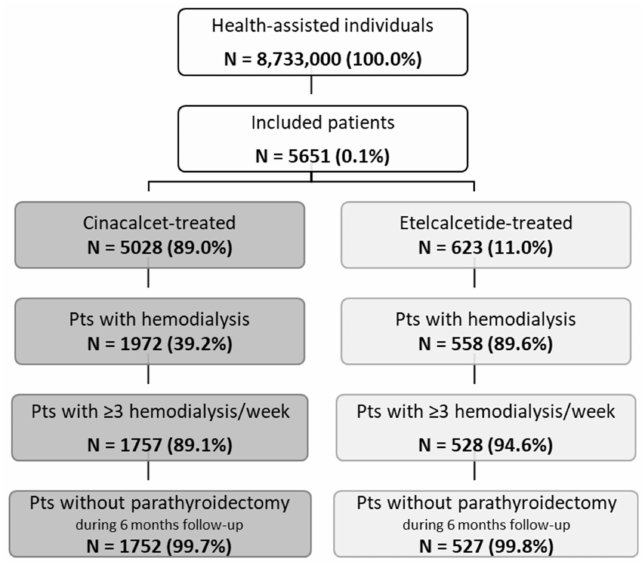
Figure 1. Flow chart of study population selection. Note: